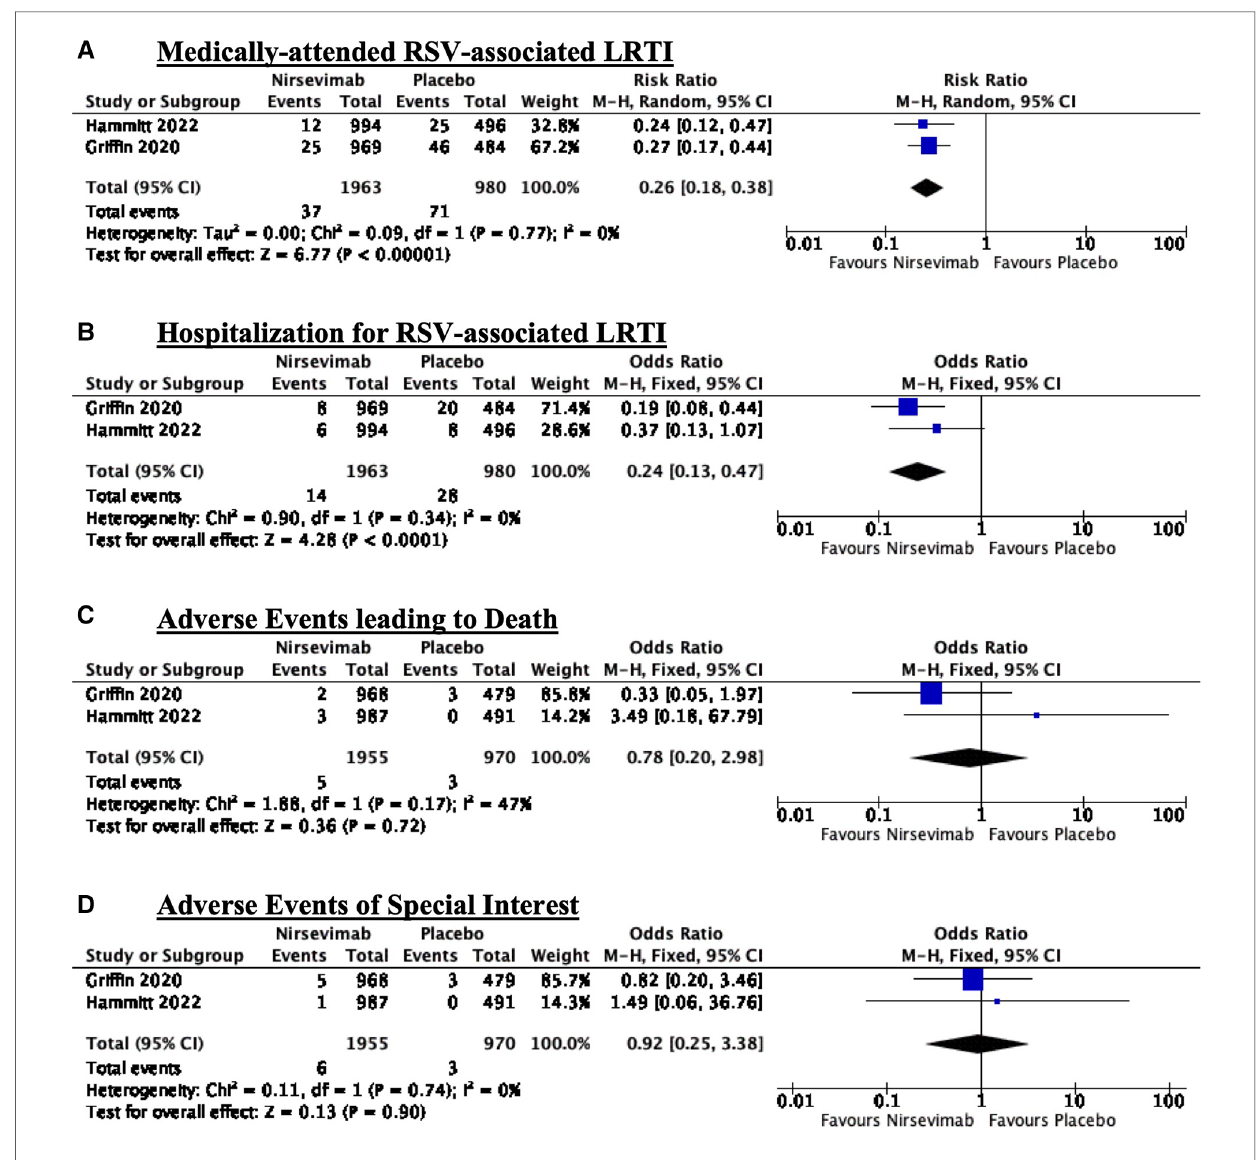
FIGURE 2 Forest plots summarizing the effects of intervention: (A) Medically-attended RSV-associated LRTI; (B) Hospitalization for RSV-associated LRTI; (C) Adverse events leading to death; and (D) Adverse events of special